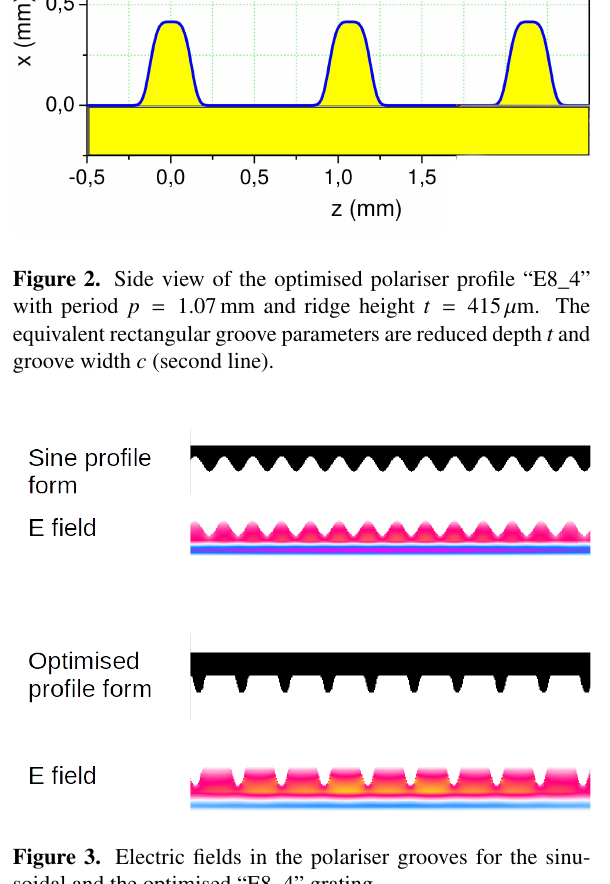
Figure 1. Geometry of the polariser simulations. The angle of incidence is always 45 ◦ . Simulations are done for E- and H- plane incident polarisation and the groove direction is measured with respect to the plane of incidence, with the 2 extreme cases indicated.